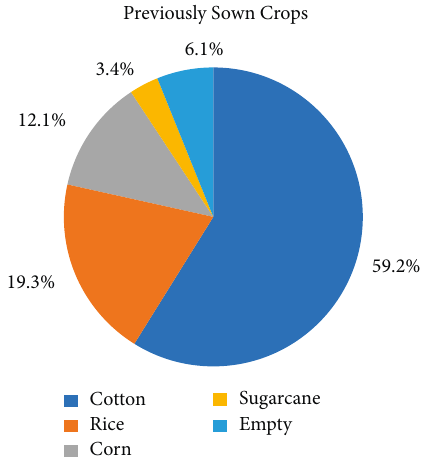
Figure 3: Pie chart for the type of water.